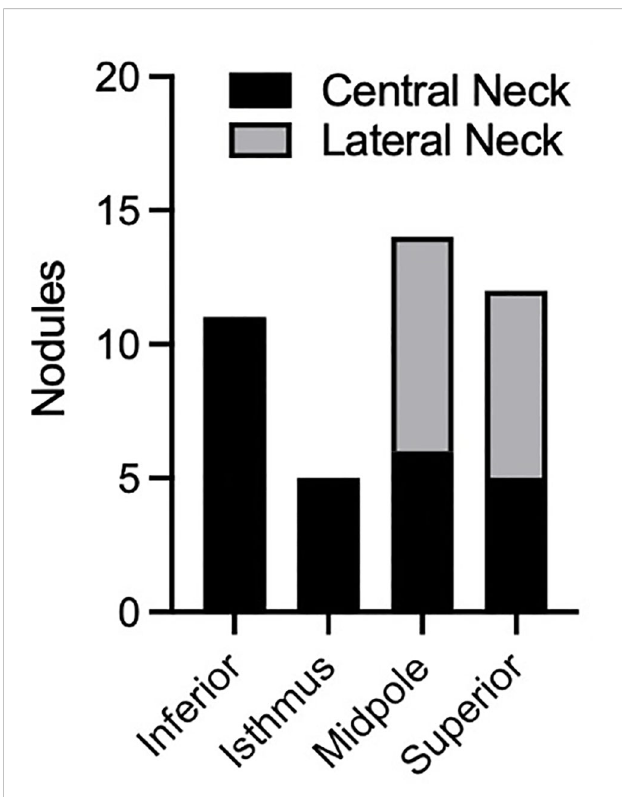
FIGURE 5 Analysis of PTMC nodules with regional metastasis. Plot displays location of nodules within the thyroid and location of notal metastasis (central or lateral neck). In TNM staging, central and lateral neck metastases are referred to as N1a and N1b disease,